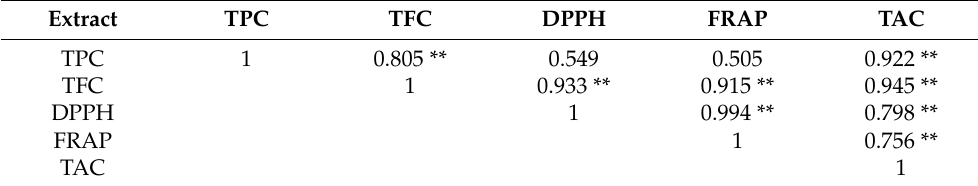
Table 5. Correlation among phenolic compounds and assays